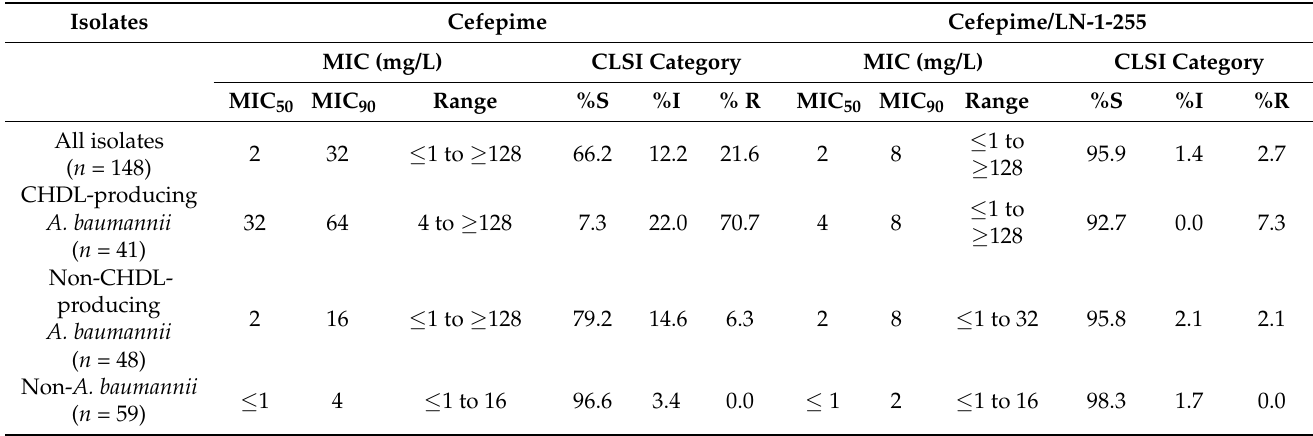
Table 4. Susceptibility of Acinetobacter spp. isolates to cefepime and cefepime/LN-1-255.